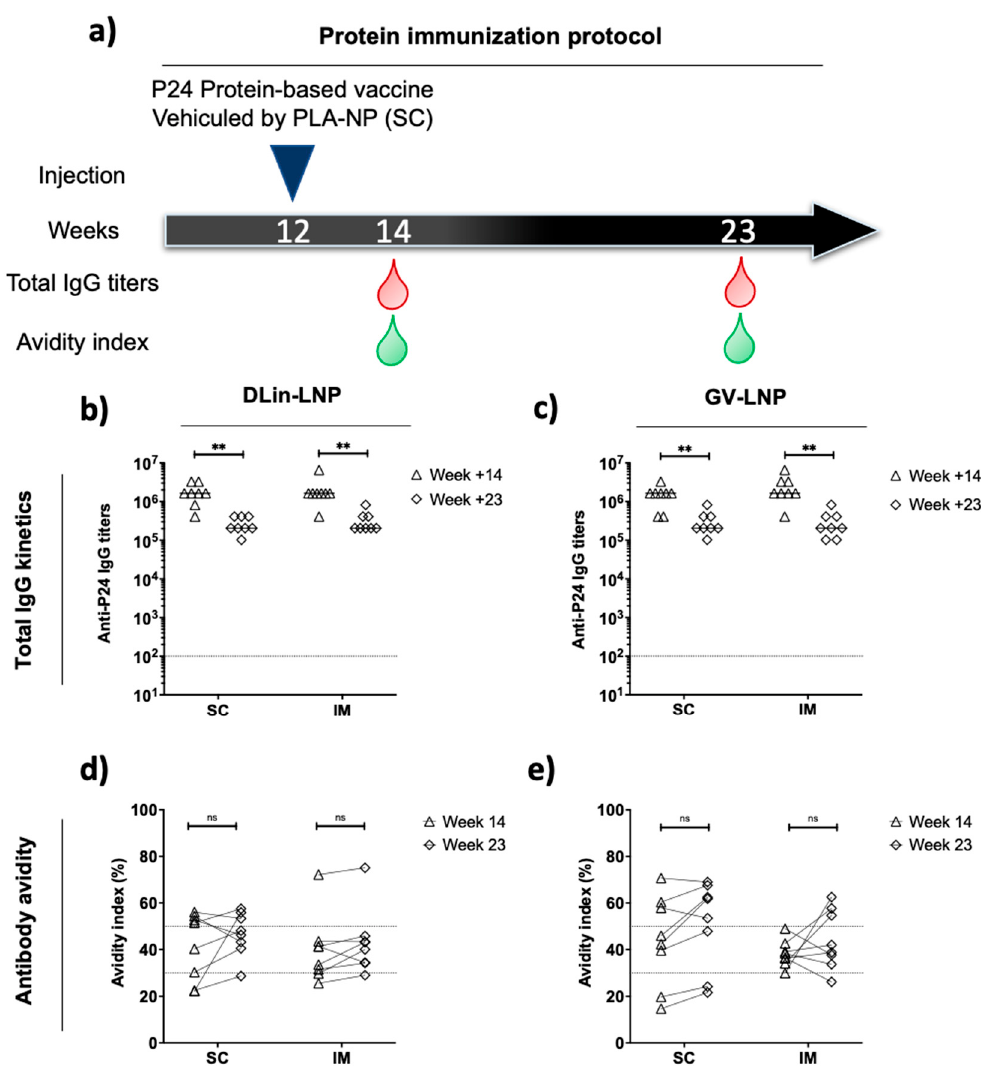
Figure 3. Subcutaneous protein heterologous boost maintained high IgG titers and did not interfere with antibody quality. Four weeks after the last mRNA injection ( a ), mice received protein-based vaccine composed of p24Gag protein loaded onto PLA-NP. Then, 3 µg of protein was administrated subcutaneously to evaluate humoral immune response ( b , c ) and its avidity ( d , e ). The nonparametric Wilcoxon test was assessed to determinate signi fi cant di ff erences ( p > 0.05: NS and p < 0.01 **).